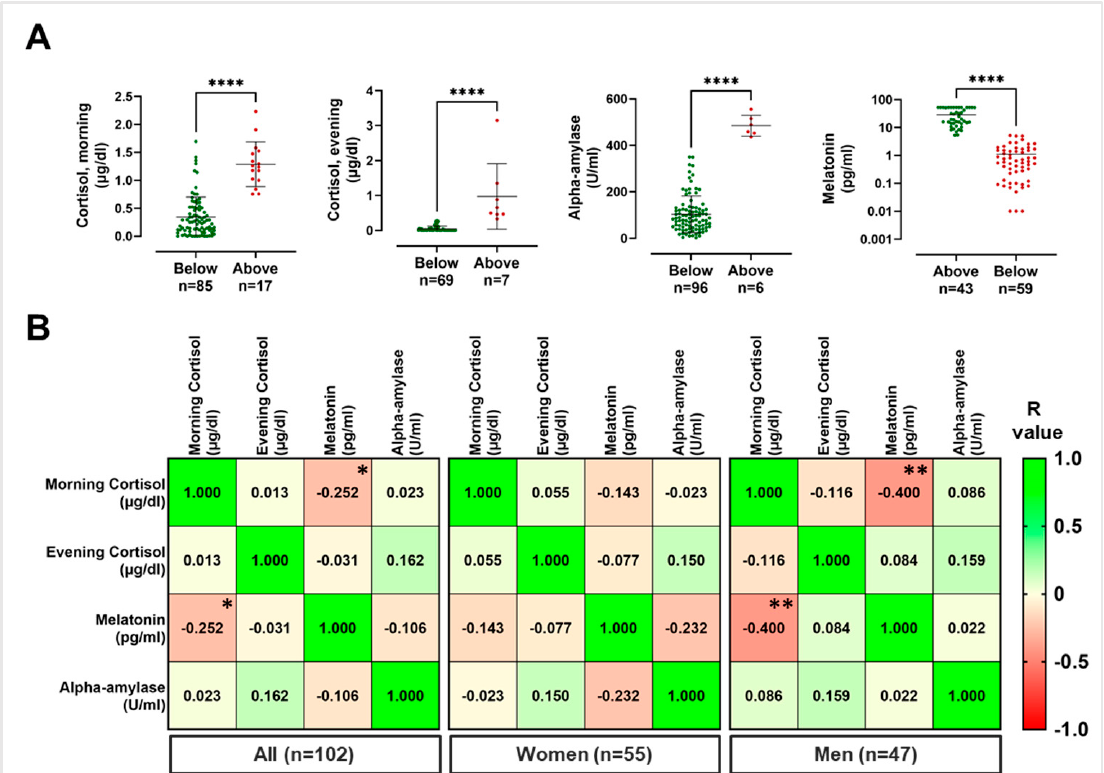
Figure 2. Salivary biomarkers analyses in nurses. ( A ) Salivary biomarker levels in nurse population; green dots indicate samples with values within the threshold limits, red dots indicate samples with values above (for cortisol and alpha-amylase) or below (for melatonin) the threshold value. ( B ) Matrix with correlation analyses among salivary biomarkers; in each square is indicated the r value, asterisks indicate a significant correlation, whereas no asterisk indicates absence of significant cor- relation. * p < 0.05; ** p < 0.01; **** p < 0.0001.